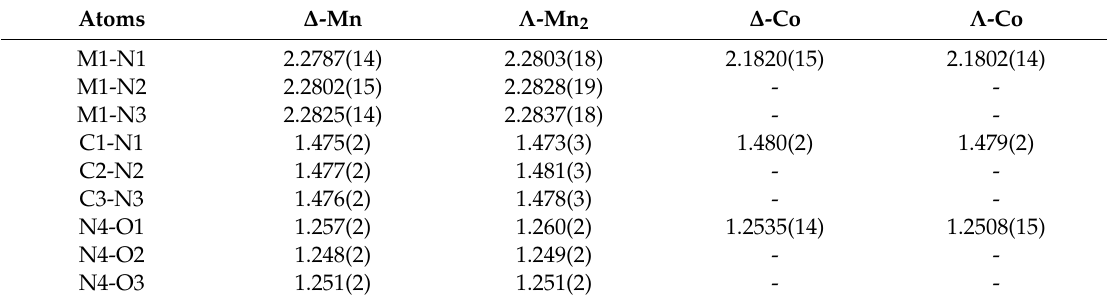
Table 4. Selected bond distances (Å) for [Mn(en) 3 ](NO 3 ) 2 and [Co(en) 3 ](NO 3 ) 2 at 120